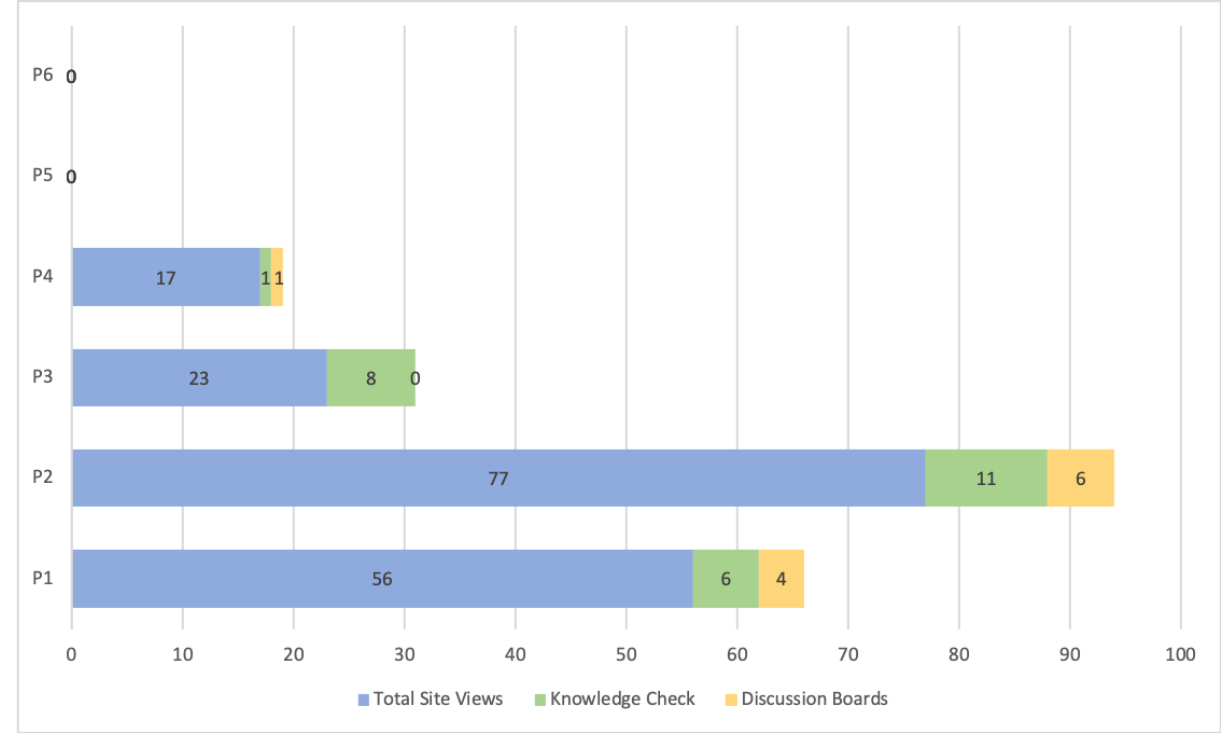
Figure 4. Overview of participant dosage and responsiveness within the intervention. P: